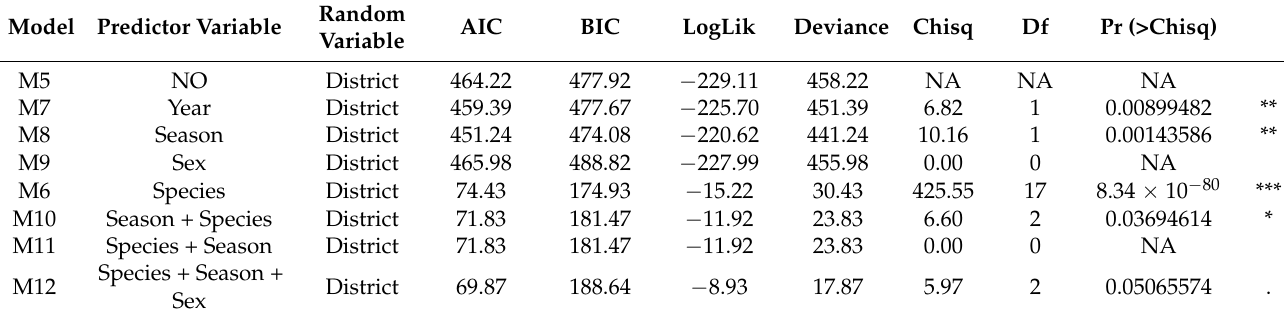
Table 5. Effect of several variables on the probability of Spiroplasma infection in the LMM. Model Predictor